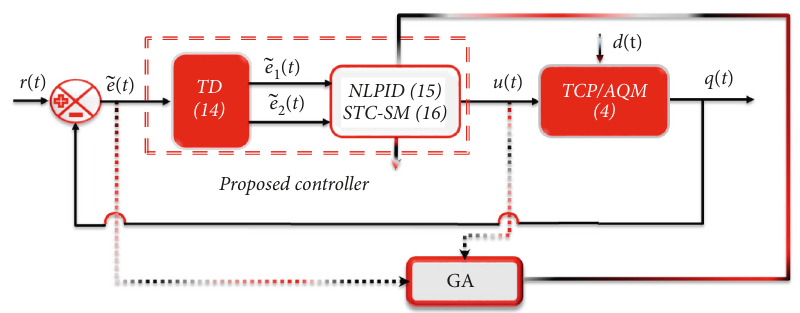
Figure 2: Completed diagram of the TCP/AQM based on the proposed controllers.